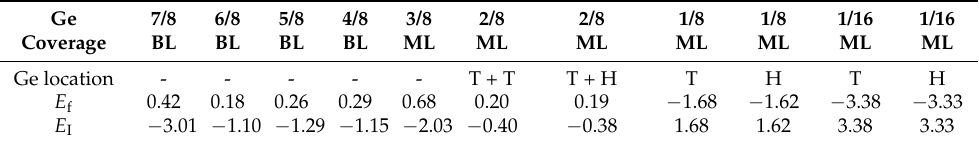
Table 1. Formation energies ( E f in eV per atom) and intercalation energies ( E I in eV) for different Ge